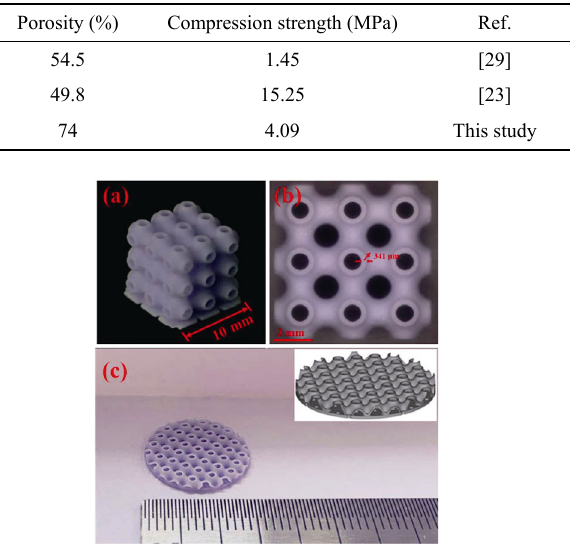
Table 1 Porosity and compression strength of HA scaffolds prepared by DLP with different structures in